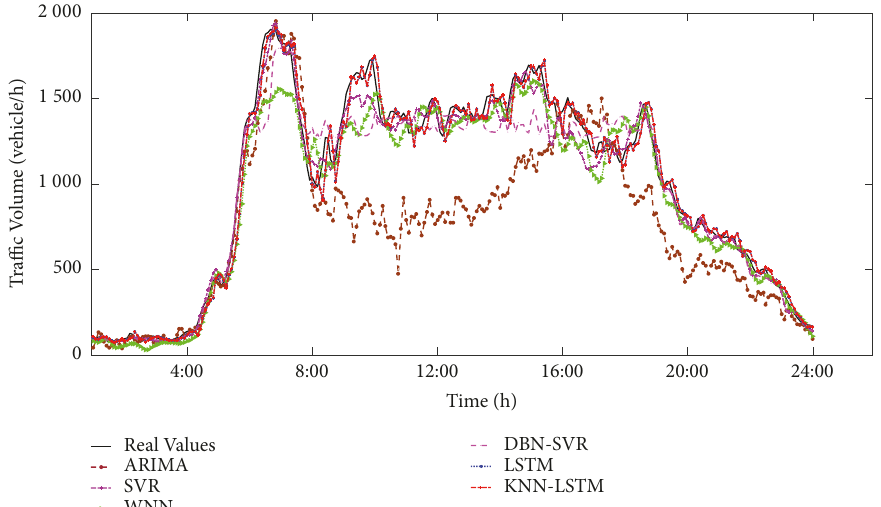
Figure 7: The real and predicted traffic flow in